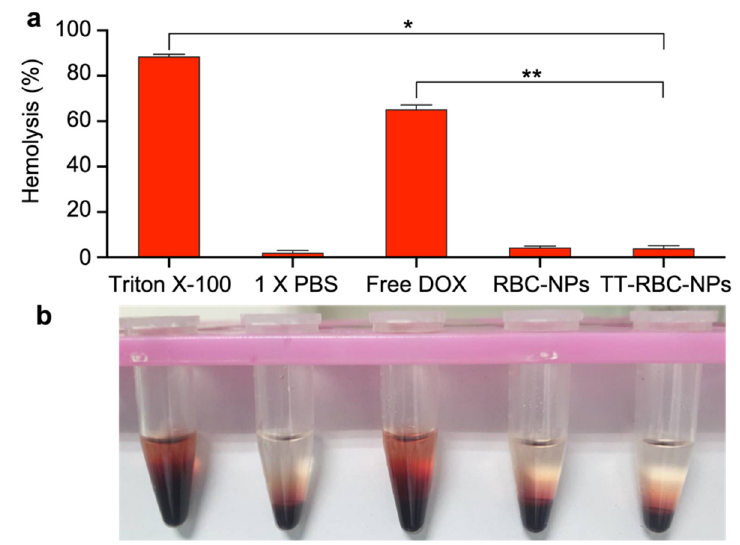
Figure 10. Hemotoxicity of TT-RBC-NPs. ( a ) Hemolysis of Triton X-100, PBS, free DOX, RBC-NPs and TT-RBC-NP (equivalent of 1 µg/mL DOX). Data represents mean ± SD ( n = 3). ( b ) Images of red blood cells treated with Triton X-100, PBS, free DOX, RBC-NPs and TT-RBC-NP (equivalent of 1 µg/mL DOX) for 48 h. * the significance between Triton X-100 and TT-RBC-NPs at 48 h incubation ( p < 0.05). * * the significance between Free DOX and TT-RBC-NPs at 48 h incubation ( p < 0.05).